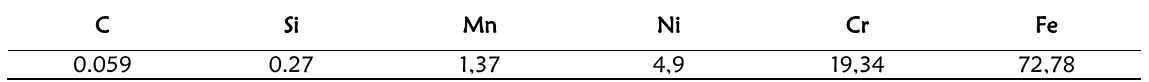
Table 1: Chemical composition of the stainless steel 304 sheet, ASTM A 240 [29].